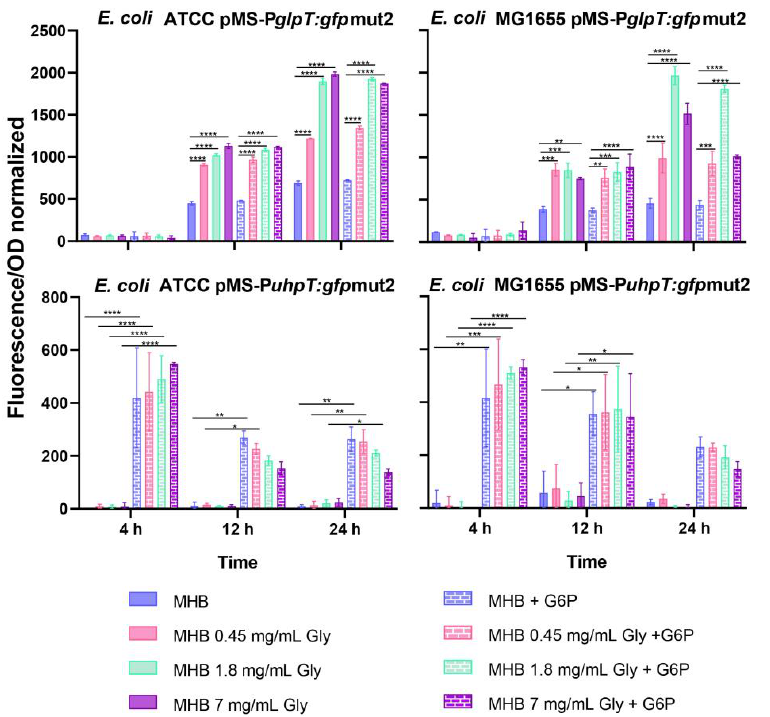
Figure 1. Induction of the glpT and uhpT genes in the ATCC25922 and MG1655 strains. Fold induction is GFP fluorescence after 4, 12, and 24 h of exposure, normalized to promoterless strains. Error bars represent standard deviation. Significant p- values compared to their corresponding (*: p < 0.05; **: p < 0.01; ***: p < 0.001; ****: p < 0.0001).